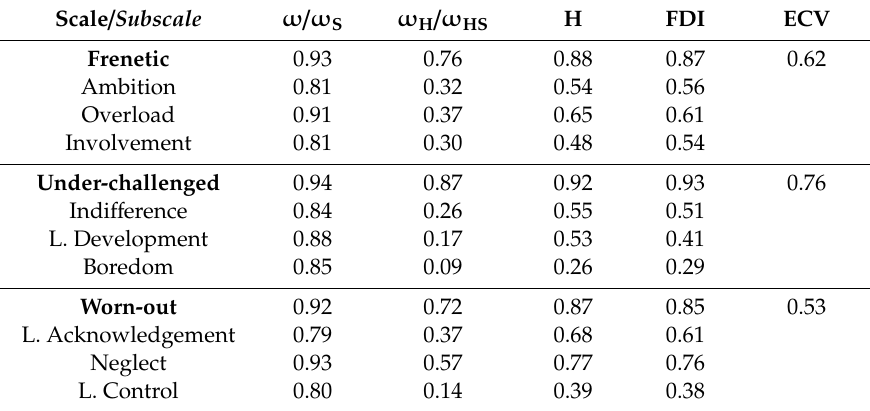
Table 4. Reliability of the BCSQ-36 bifactor